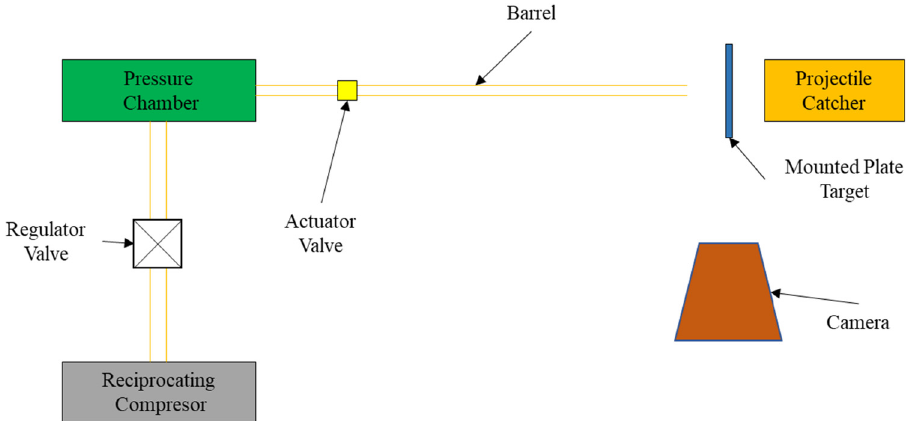
Figure 3: Schematic experiment.